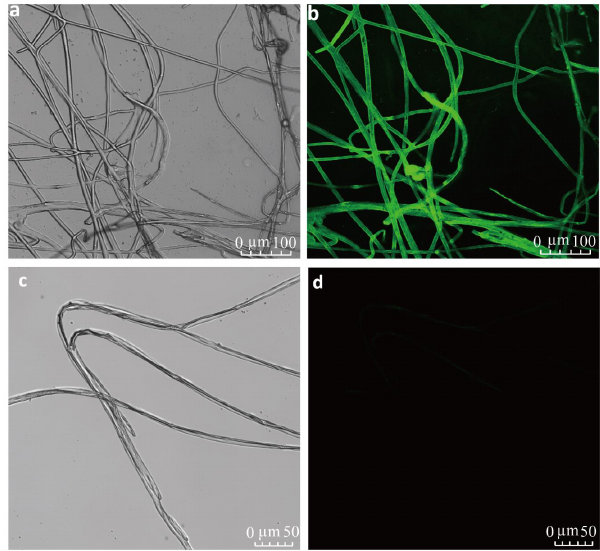
Figure 3. Expression of EGFP in transformed Ascosphaera apis ( A. apis ) mutant mycelia with plasmid containing EGFP and wild-strain group viewed using a confocal laser scanning microscope illuminated with a UV light. ( a , b ) Mycelia of transformed A. apis StcU-2 mutants expressing EGFP . ( c , d ) Mycelia of A. apis wild strain (non-transformed) without expressing EGFP